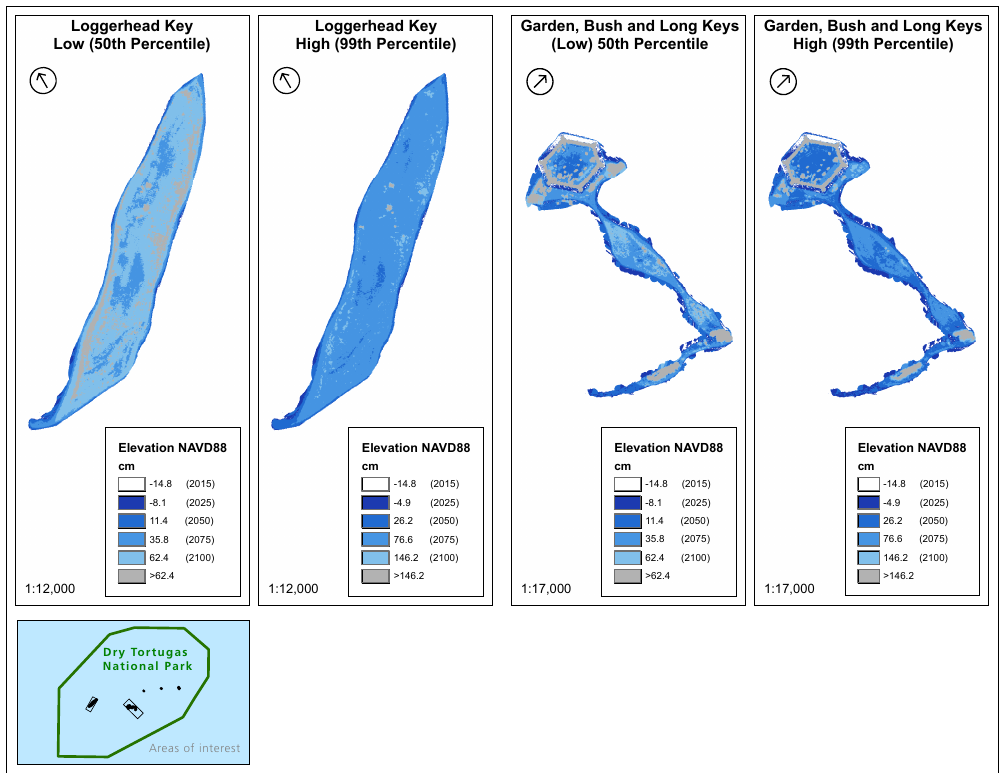
Figure 8. Mean sea level elevation maps for Dry Tortugas National Park at Loggerhead, Garden, Bush and Long Keys for the median (50th) and high (99th percentile) RCP 8.5 projections. Tides and storm surges are not included in this